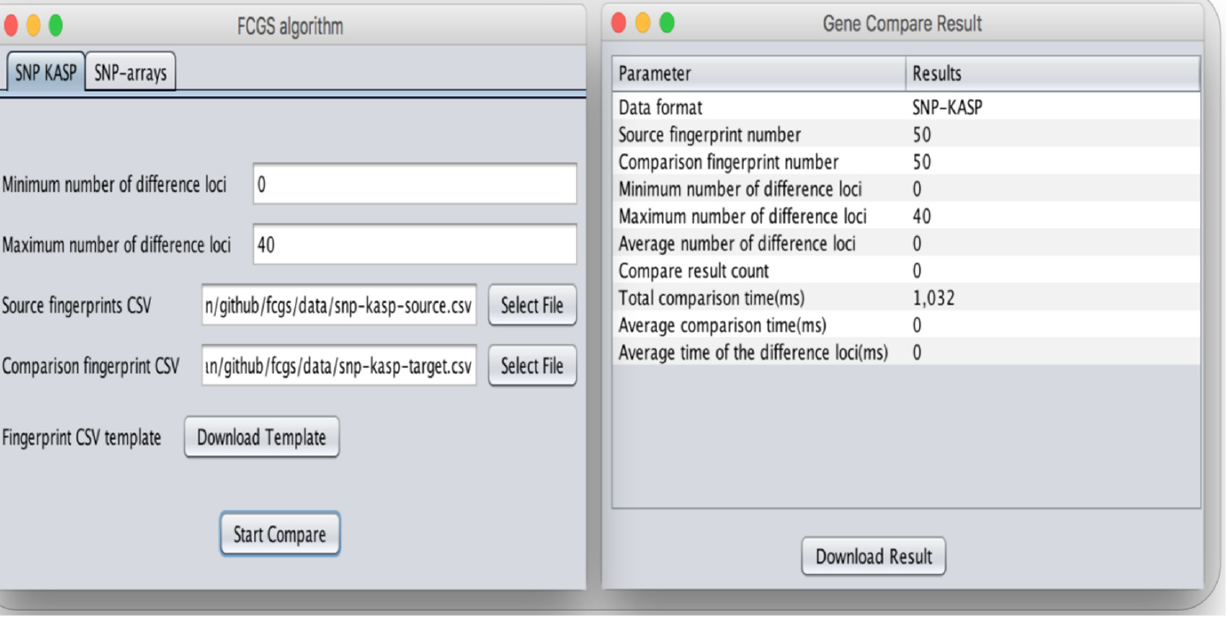
Figure 2. Additional software and website of FCGS. Graphical user interface (GUI) software. This software uses CSV fingerprint data format. The user can download the sample template of data format with the “Download Template” button and click on the “Start Compare” button. After comparison, the matrix table of the comparison results can be downloaded from the “Download Result” button in the comparison result interface. The fingerprint number, result record, and usage time of the comparison will be displayed on the